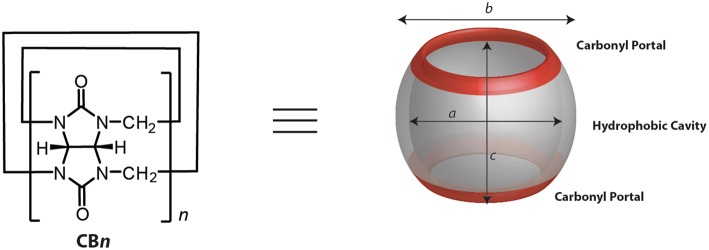
Chemical and model representations of CBn.